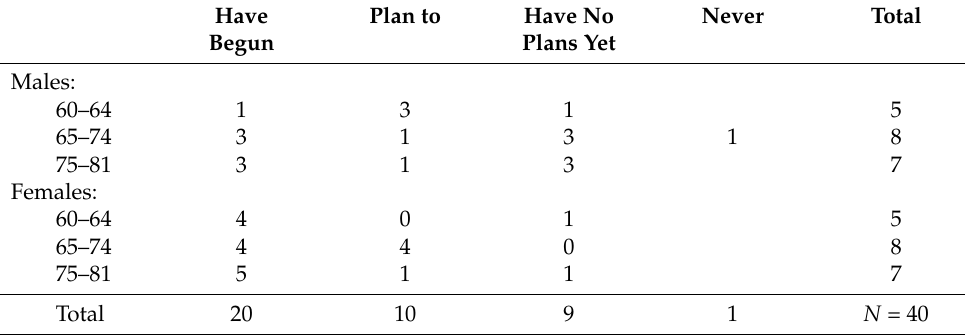
Table 4. Number of respondents engaging in Sh ū katsu .